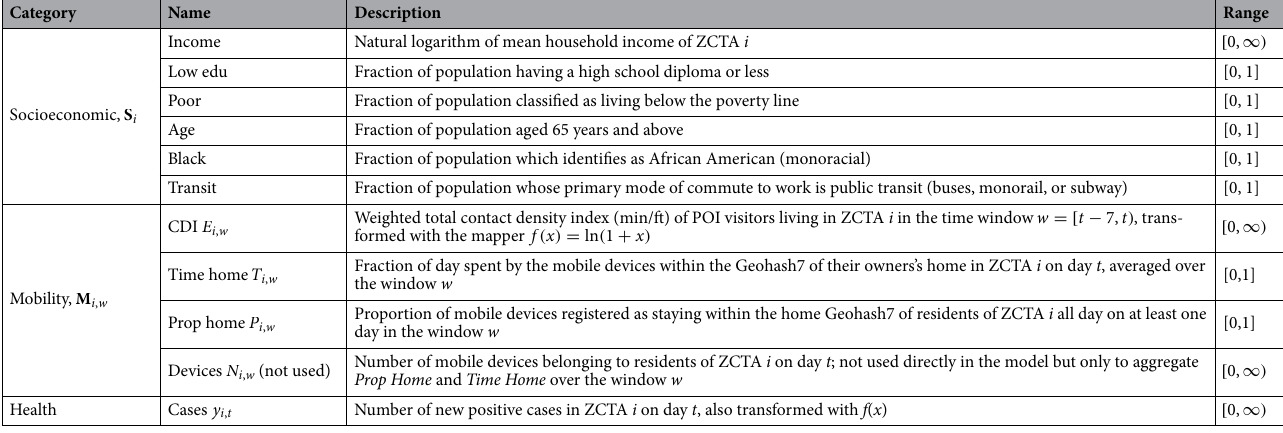
Table 1. Description of SEM variables. Description of the independent, target, and latent variables used in the daily structured equations models, along with their symbols and